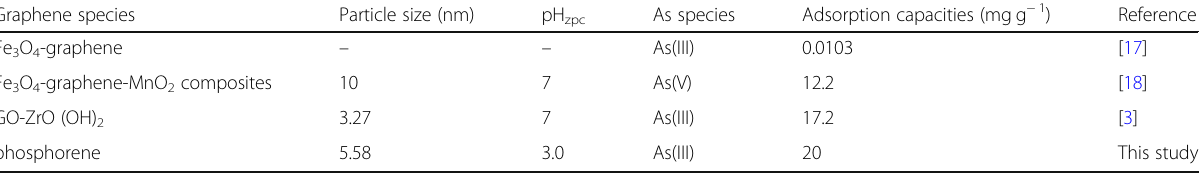
Table 2 Comparisons of phosphorene adsorption with various adsorbents Graphene